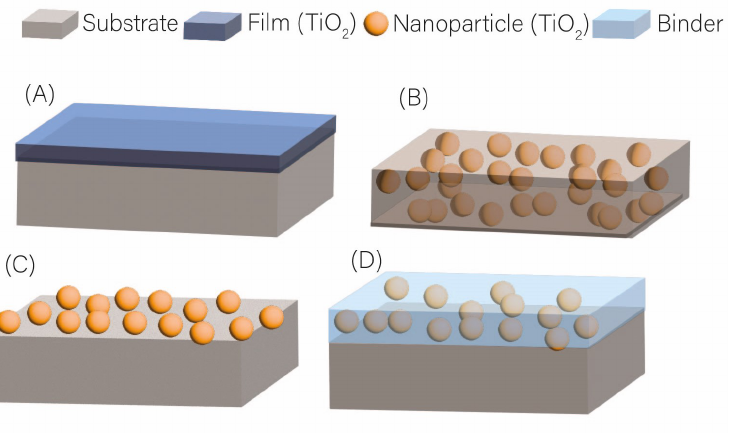
Figure 7. Multiple ways for preparation of titania at surfaces: Homogeneous TiO 2 film ( A ), titania nanoparticles suspended in substrate ( B ), titania nanoparticles directly applied to the surface ( C ), and titania nanoparticles in a coating layer ( D